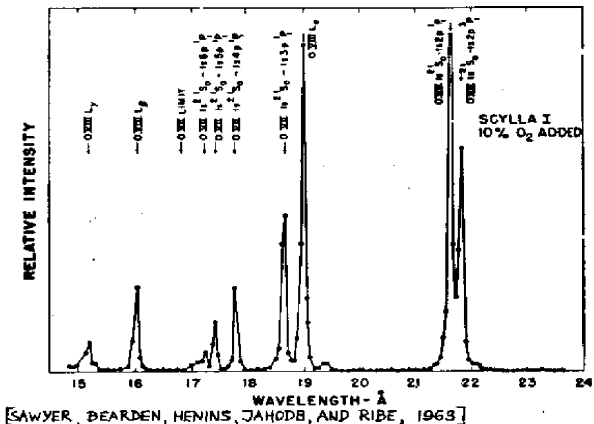
Figure 11: SLaboratory spectrum in the XUV region from 2.4-1.5 nm (Sawyer et al., Figure 11. Laboratory spectrum in the XUV region from 2.4– 1963, Copyright permission granted by American Physical Society). 1.5nm (Sawyer et al., 1963; copyright permission granted by the American Physical Society).